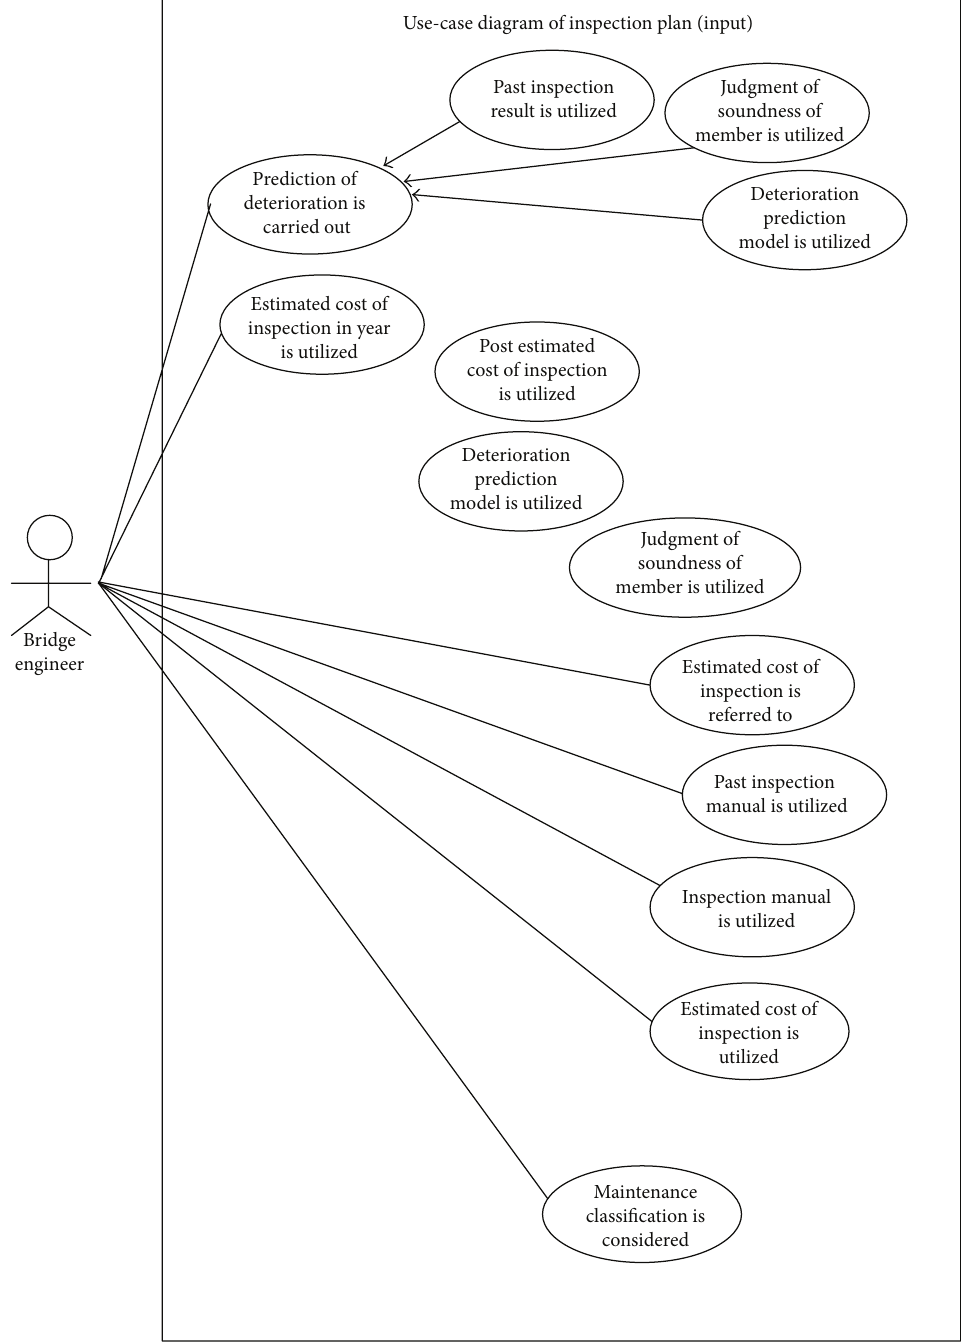
Figure 4: Required function of input data of inspection